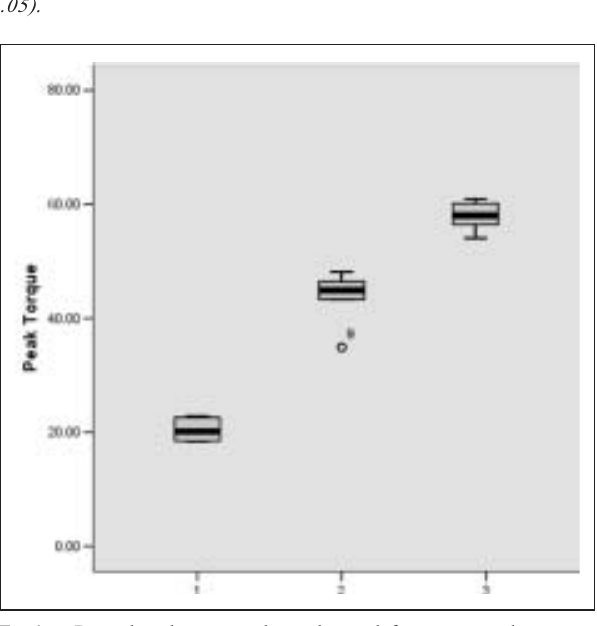
Fig.1 - Box plot showing values obtained from torsional strength tests performed within the groups